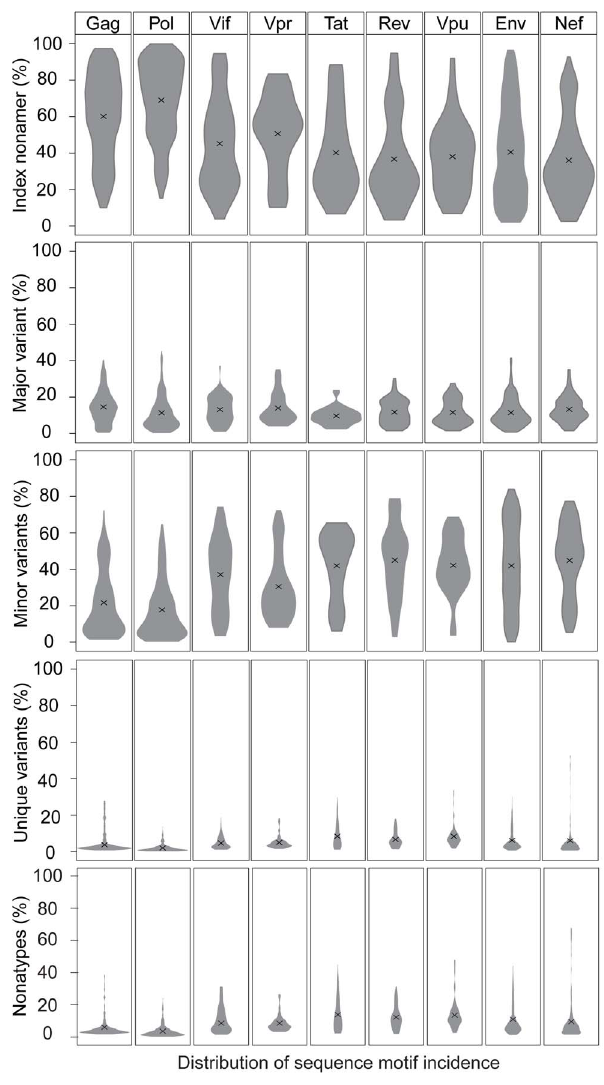
Figure 6. Frequency distribution violin plots of the diversity motifs incidences of HIV-1 clade B proteins. The legend for the violin plot is described in Figure 4.